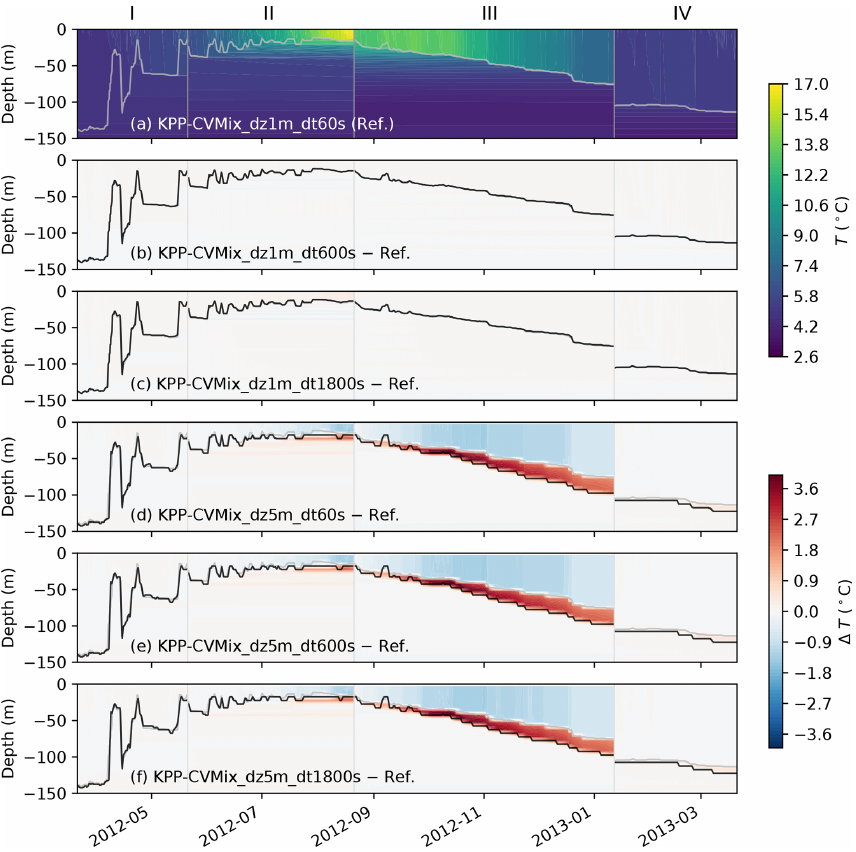
Figure 14. Similar to Fig. 6, but showing the differences in the simulated temperature at Ocean Station Papa in KPP-CVMix with different vertical resolution and time step. Panel (a) shows the simulated temperature in the finest resolution and time step as in Fig. 6 (the reference). Panels (b) – (f) show the differences from the reference with different combinations of coarser vertical resolution and larger time